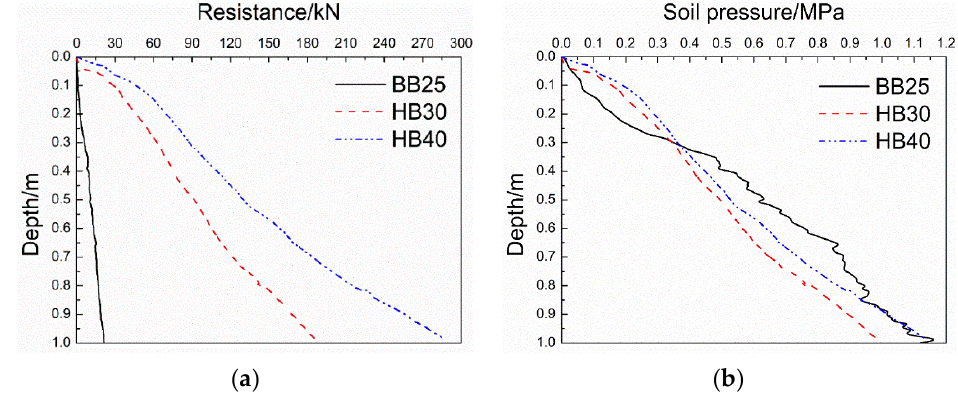
Figure 9. Sinking resistance and unit-end soil pressure: ( a ) Resistance; ( b ) End soil pressure.